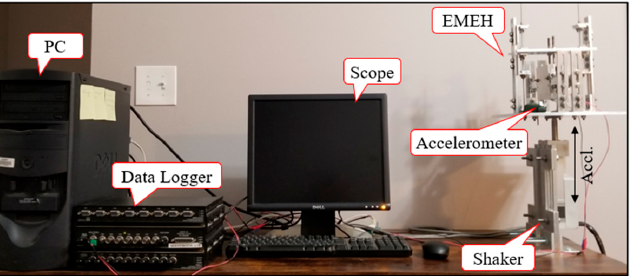
Figure 10. Experimental setup established to test the proof-of-concept prototype of EMEH in a laboratory environment under harmonic excitations.